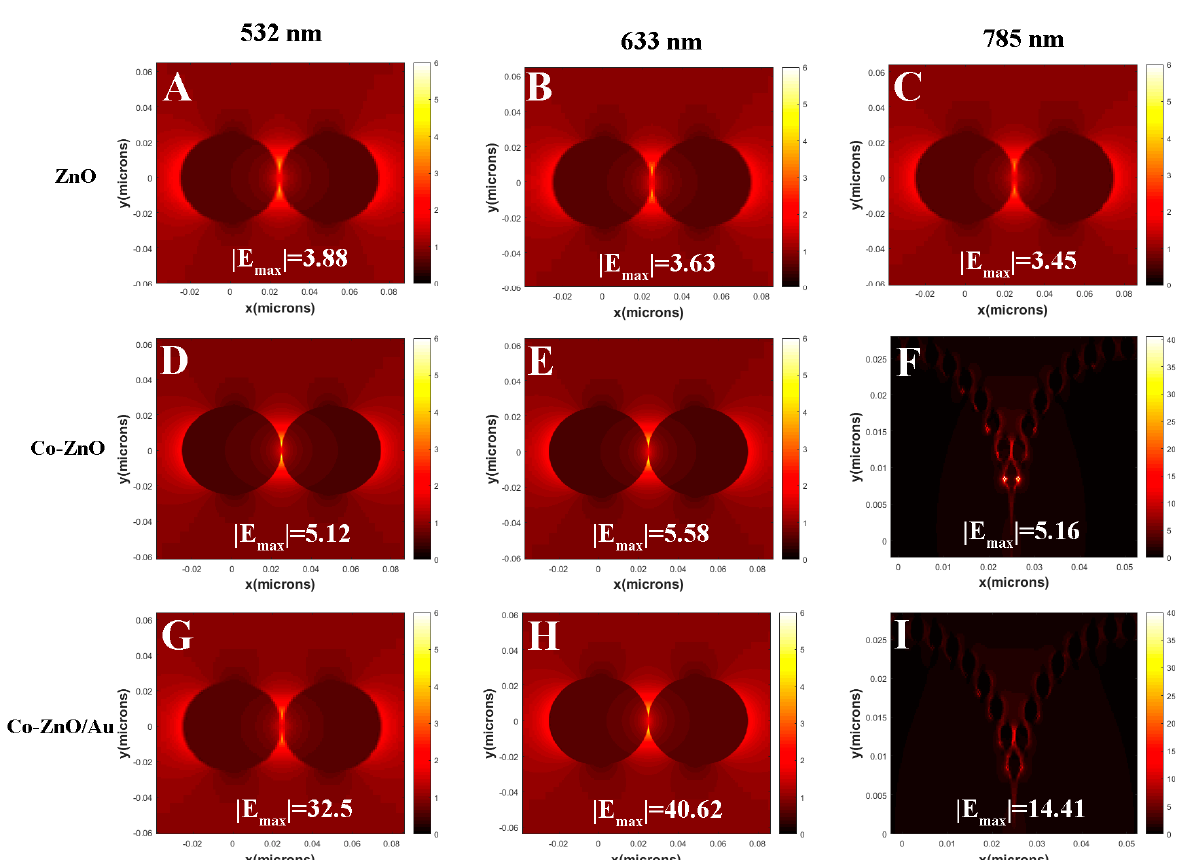
Figure 6. Electromagnetic field enhancement of ZnO, Co − ZnO, and Co − ZnO/Au nanostructures by using finite difference time domain simulations: ( A – C ) ZnO structure in xy axial under 532 nm laser; ( D – F ) Co − ZnO structure in xy axial under 633 nm laser; ( G – I ) ZnO structure in xy axial under 785 nm laser.